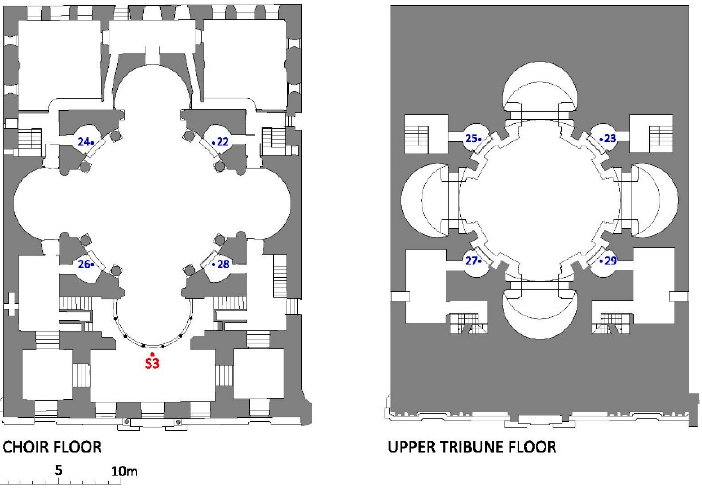
Figure 8. Choir and upper tribune floor. Receivers located in stands for novices.